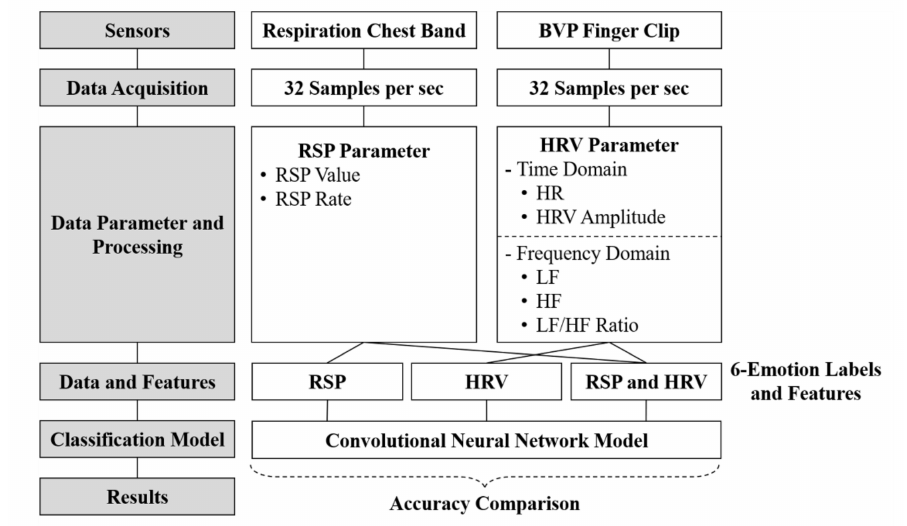
Figure 5. Procedure for comparing and selecting the classification model.